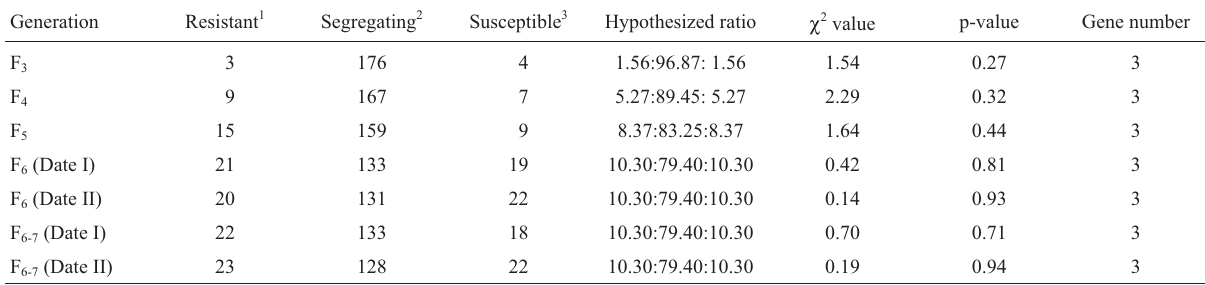
Table 3 - Goodness of fit of ratios observed and hypothesized class frequencies for F 3 , F 4 , F 5, F 6 and F 6-7 lines from the cross between resistant (IBON 18) and susceptible (RD 2508) parents. Generation Resistant 1